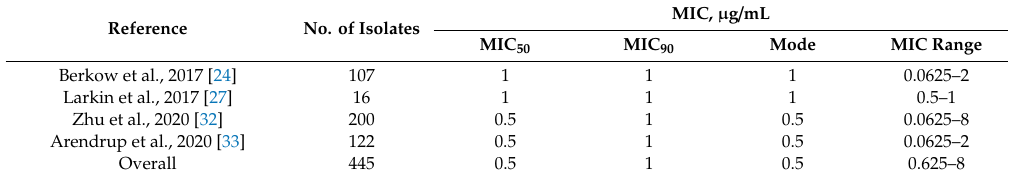
Table 2. In vitro activity of ibrexafungerp against a compilation of 445 C. auris isolates